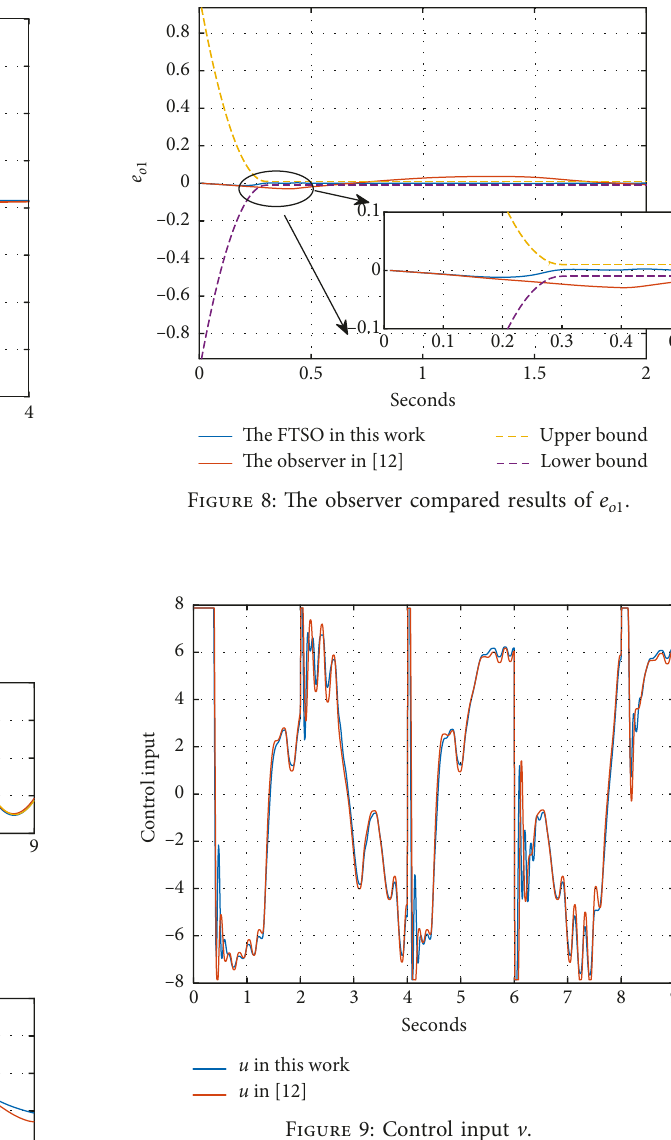
Figure 9: Control input v .